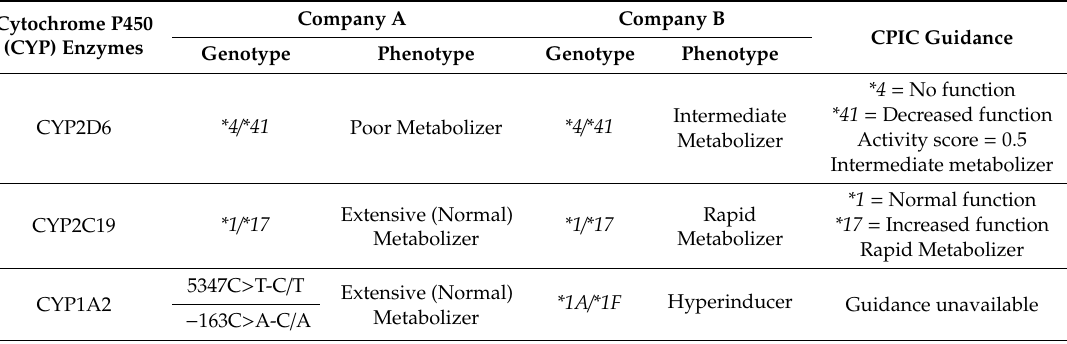
Table 1. Genotype and phenotype reports from Company A and Company B along with available Clinical Pharmacogenetics Implementation Consortium (CPIC)